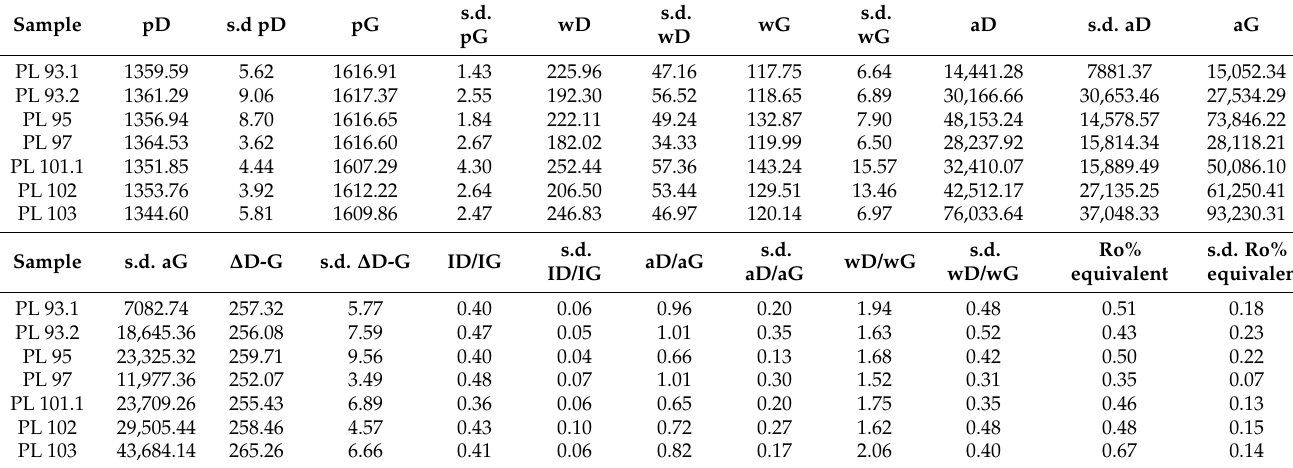
Table 3. Mean values of Raman parameters for each sample, calculated by means of the automatic deconvolution proposed by Schito and Corrado (2018). pD, position of the D band (cm − 1 ); pG, position of the G band (cm − 1 ); wD, full width at the maximum height of the D band (cm − 1 ); wG, full width at half maximum of the D band (cm − 1 ); aD, integrated area of the D band; aG, integrated area of the G band; ∆ D–G: difference between G band and D band position (cm − 1 ); ID/IG, intensity ratio between the D and G bands; aD/aG, area ratio between the D and G bands; wD/wG, ratio between the full width at half maximum of D and G